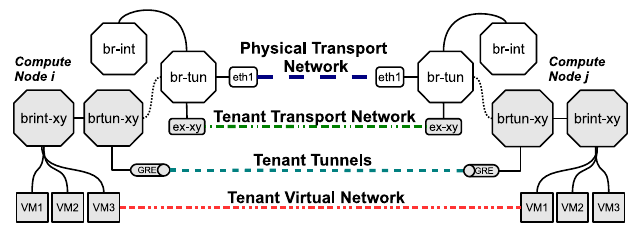
Fig. 2: Logical and physical